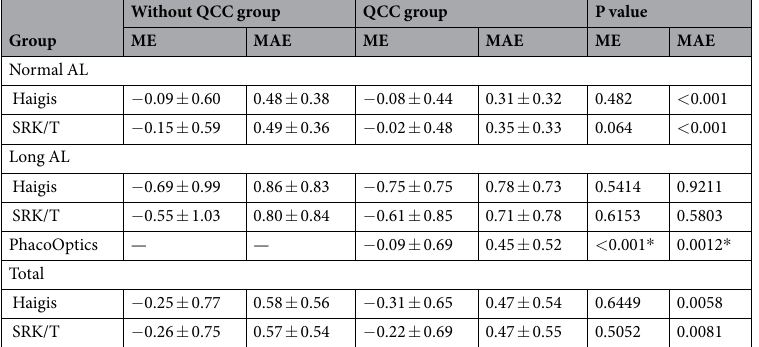
Table 3. Refractive outcomes of Haigis and SRK/T formulas in patients with different axial lengths in the two groups. QCC = Quality control circle, AL = Axial length, ME = Mean prediction error, MAE = Mean absolute prediction error. * The P value comes from comparing the results of PhacoOptics software with those of the Haigis and SRK/T formulas after the QCC activity.